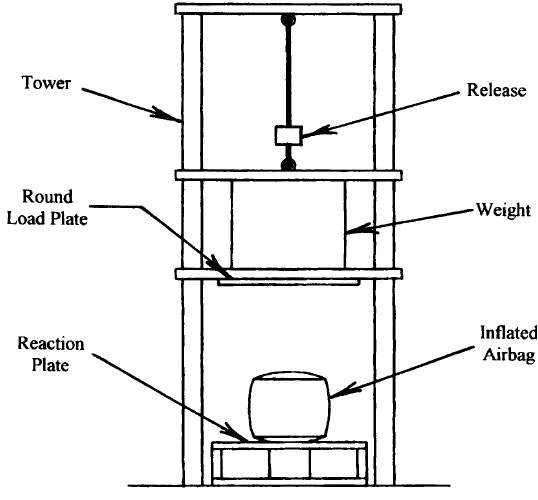
Fig. 1. Ride-down test